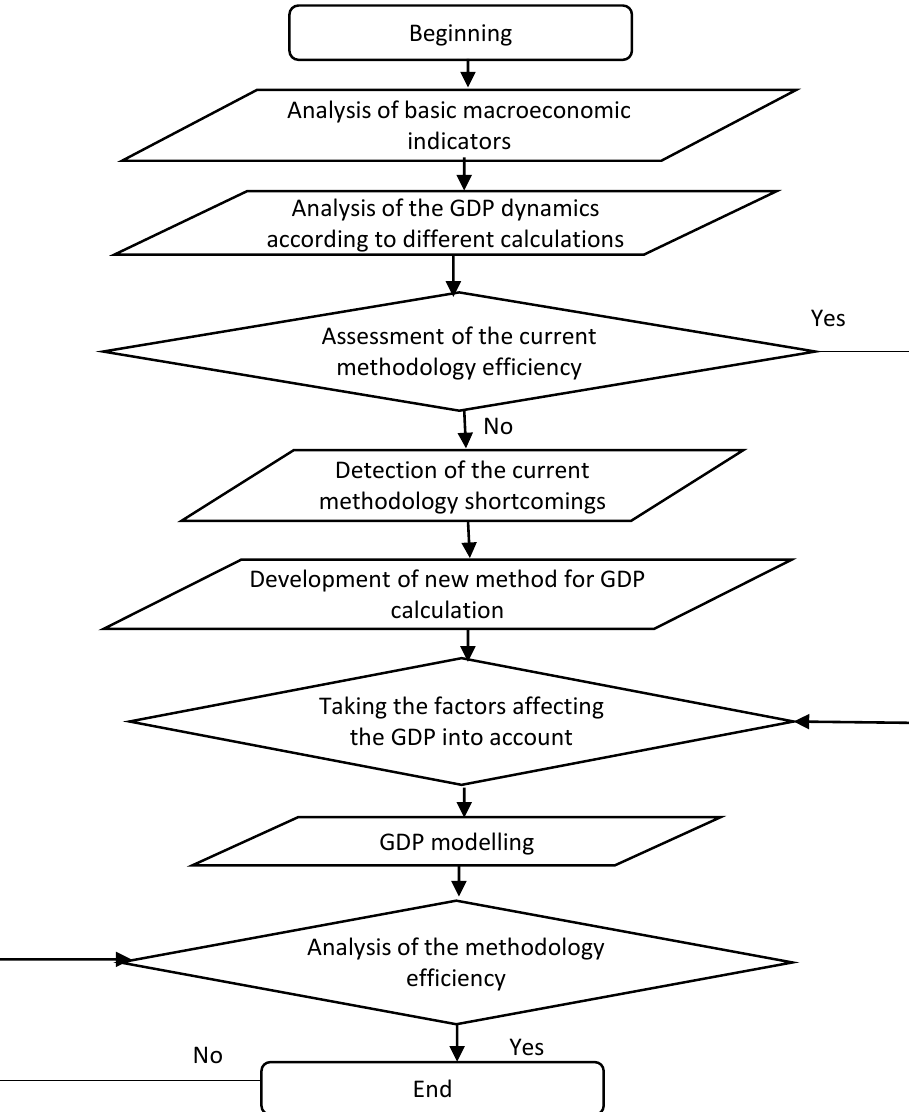
Figure 1. Algorithm for conducting the